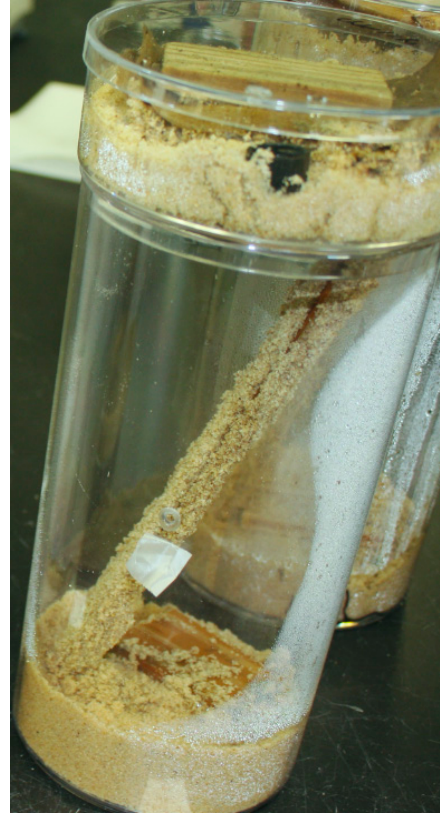
Figure 3. Shelter tube construction and termites on ramp at chlorantraniliprole 1 ppm treatment.